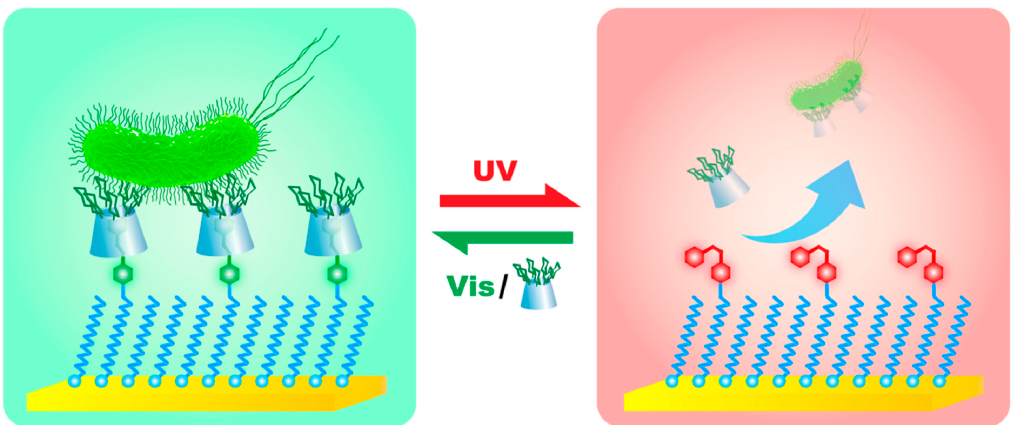
Figure 3. To switch the bacteria-capture state (green part, trans- form of Azo) to the bacteria-release state (red part, cis-form of Azo), the gold surface covered by azo derivative hosting β -cyclodextrin with covalently attached mannose units, was irradiated with 36 nm UV light for 30 min. To switch the bacteria-release state back to bacteria-capture state, the interface was irradiated with 450-nm visible light for 30 min and then immersed it into a fresh cyclodextrin-mannose solution. Reproduced with permission from [47]. Copyright American Chemical Society, 2017.